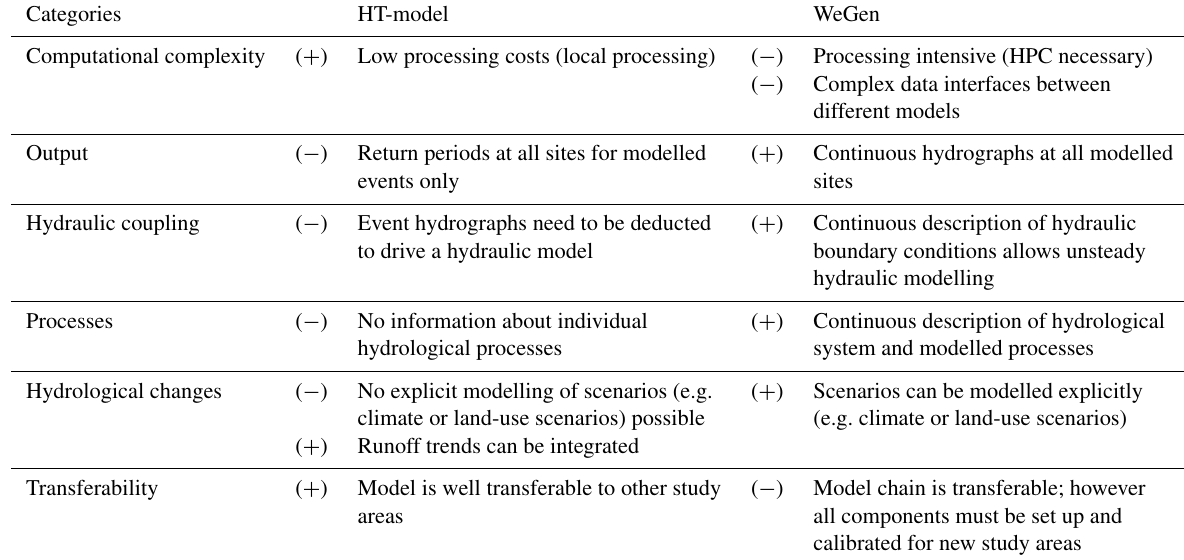
Table 1. Summary of advantages and disadvantages of the WeGen and HT-model approach to generating heterogeneous flood events.